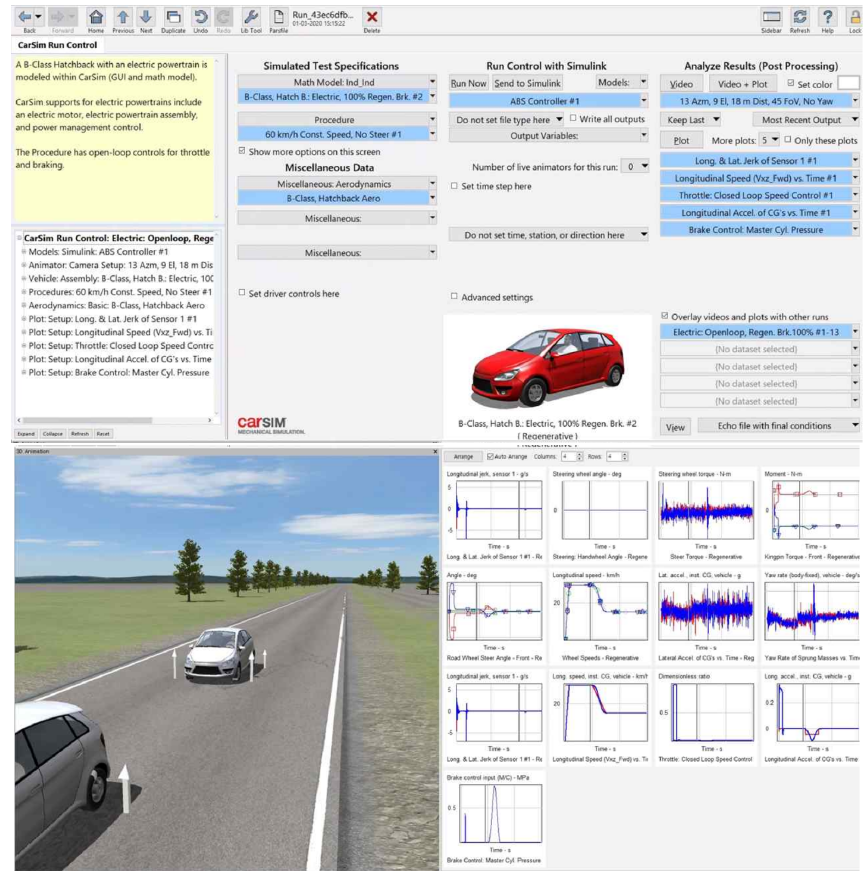
Figure 16. CarSim